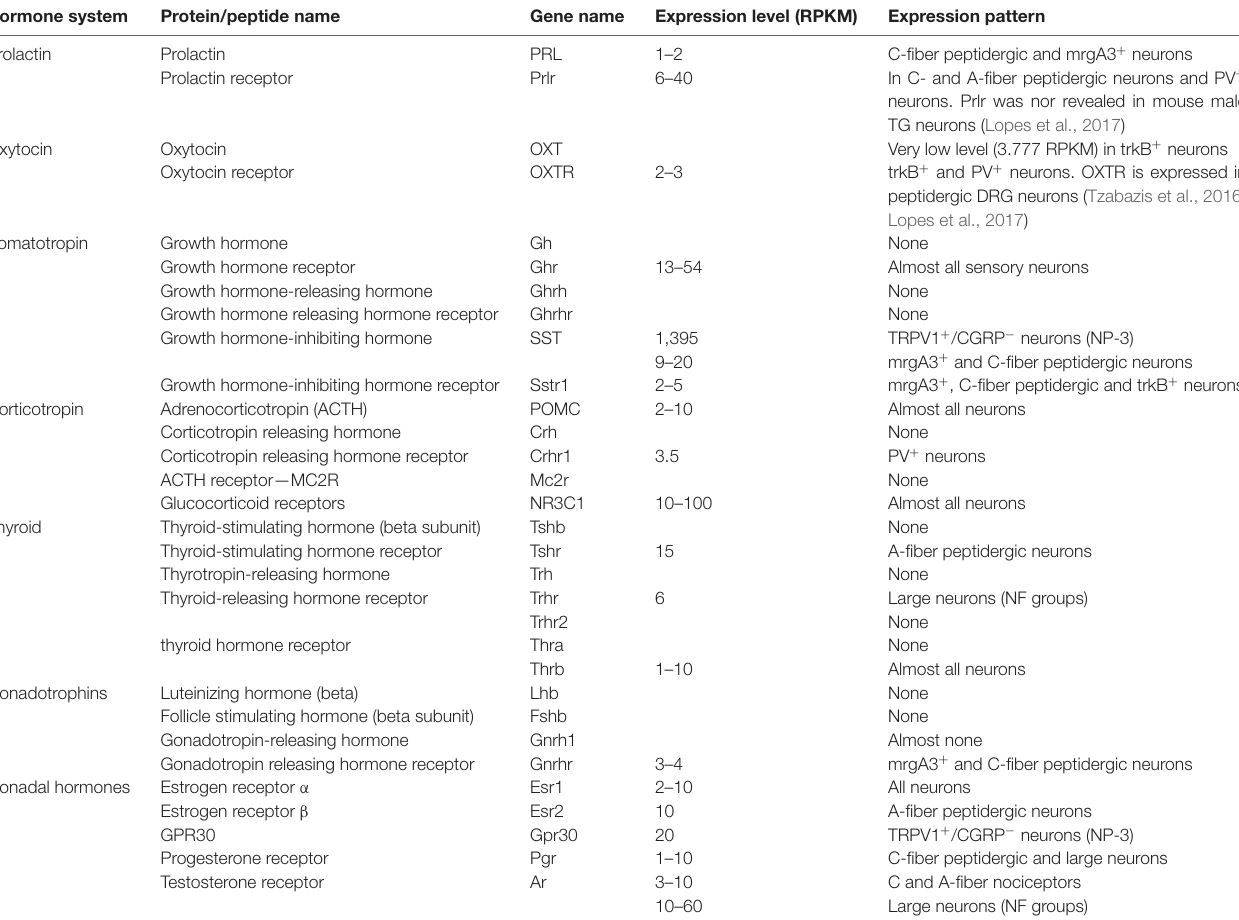
TABLE 1 | Expression of pituitary and gonadal hormones (GnH), their releasing hormones and receptors in male mouse dorsal root ganglia (DRG) sensory neurons. Hormone